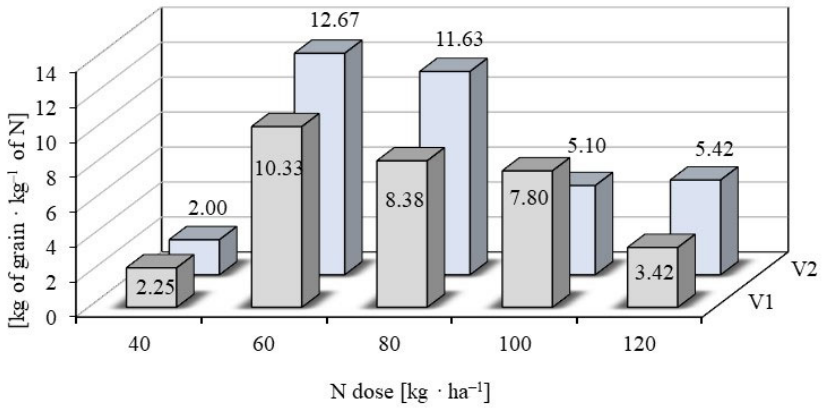
Figure 5. Grain yield of winter wheat genotypes depending on nitrogen and sulfur fertilization. Table 3. Grain yield (Mg ∙ ha − 1 ) of winter wheat genotypes under fertilization.